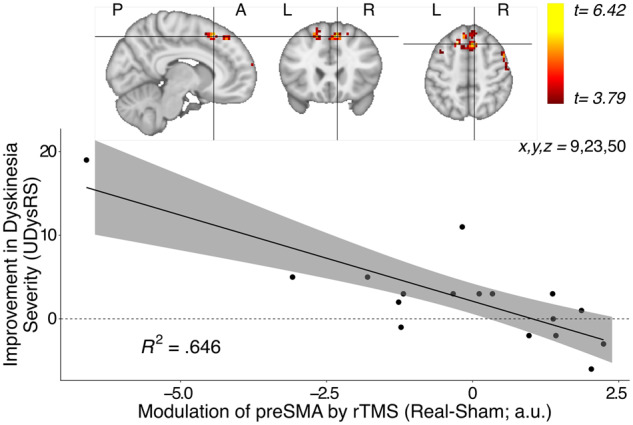

Linear increase in neural activity during no-go trials covarying with rTMS-induced improvement in dyskinesia severity. (A) During no-go trials, preSMA activity parametrically modulated by time covaried with rTMS-induced improvement in dyskinesia. The largest effect was in the anterior part of the right preSMA (peak Z-score = 4.26, x, y, z = 9, 23, 50, P = 0.002, cluster extent = 105 voxels) (B) The patients who showed the largest improvement in dyskinesia severity scores following real-rTMS had a lower increase of their preSMA activity for no-go trials over time compared with sham-rTMS.